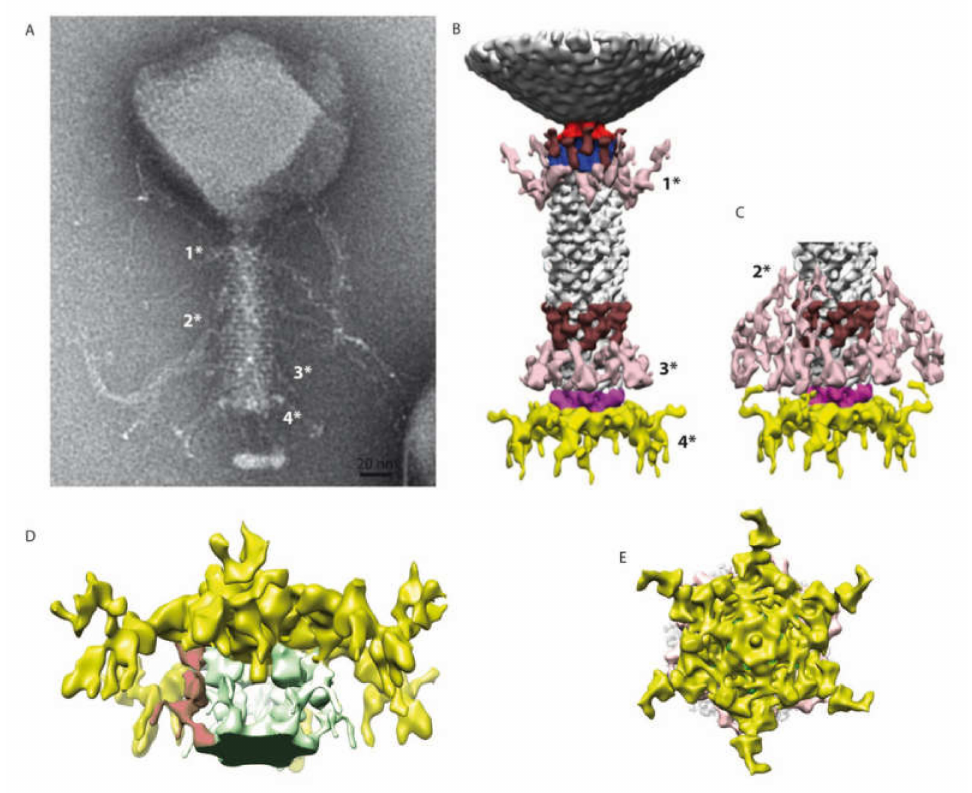
Figure 5. 3D reconstruction of the entire tail. ( A ) A negative staining image of phAPEC6. The di ff erent fibers are labeled 1*, 2*, 3* and 4* (for the baseplate one). ( B ) 3D reconstruction of the entire tail at a normal threshold (resolution 25 Å). The baseplate plus fiber are colored in yellow and pink; the di ff erent fibers anchored in the tail (1*, 2* and 3*) are in light pink; a decoration protein present at 2 levels of the tail is colored in brown and the collar and the portal are colored respectively in blue and red. ( C ) Distal part of the tail at a high contour level: the fibers located at the 2*-level are visible. The same color code as in B has been used. ( D ) Detail of the baseplate at a higher contour level. The host membrane patch (green), as well as some fibers connected to the membrane, are visible (red). ( E ) Bottom view of the baseplate showing the complex organization of this